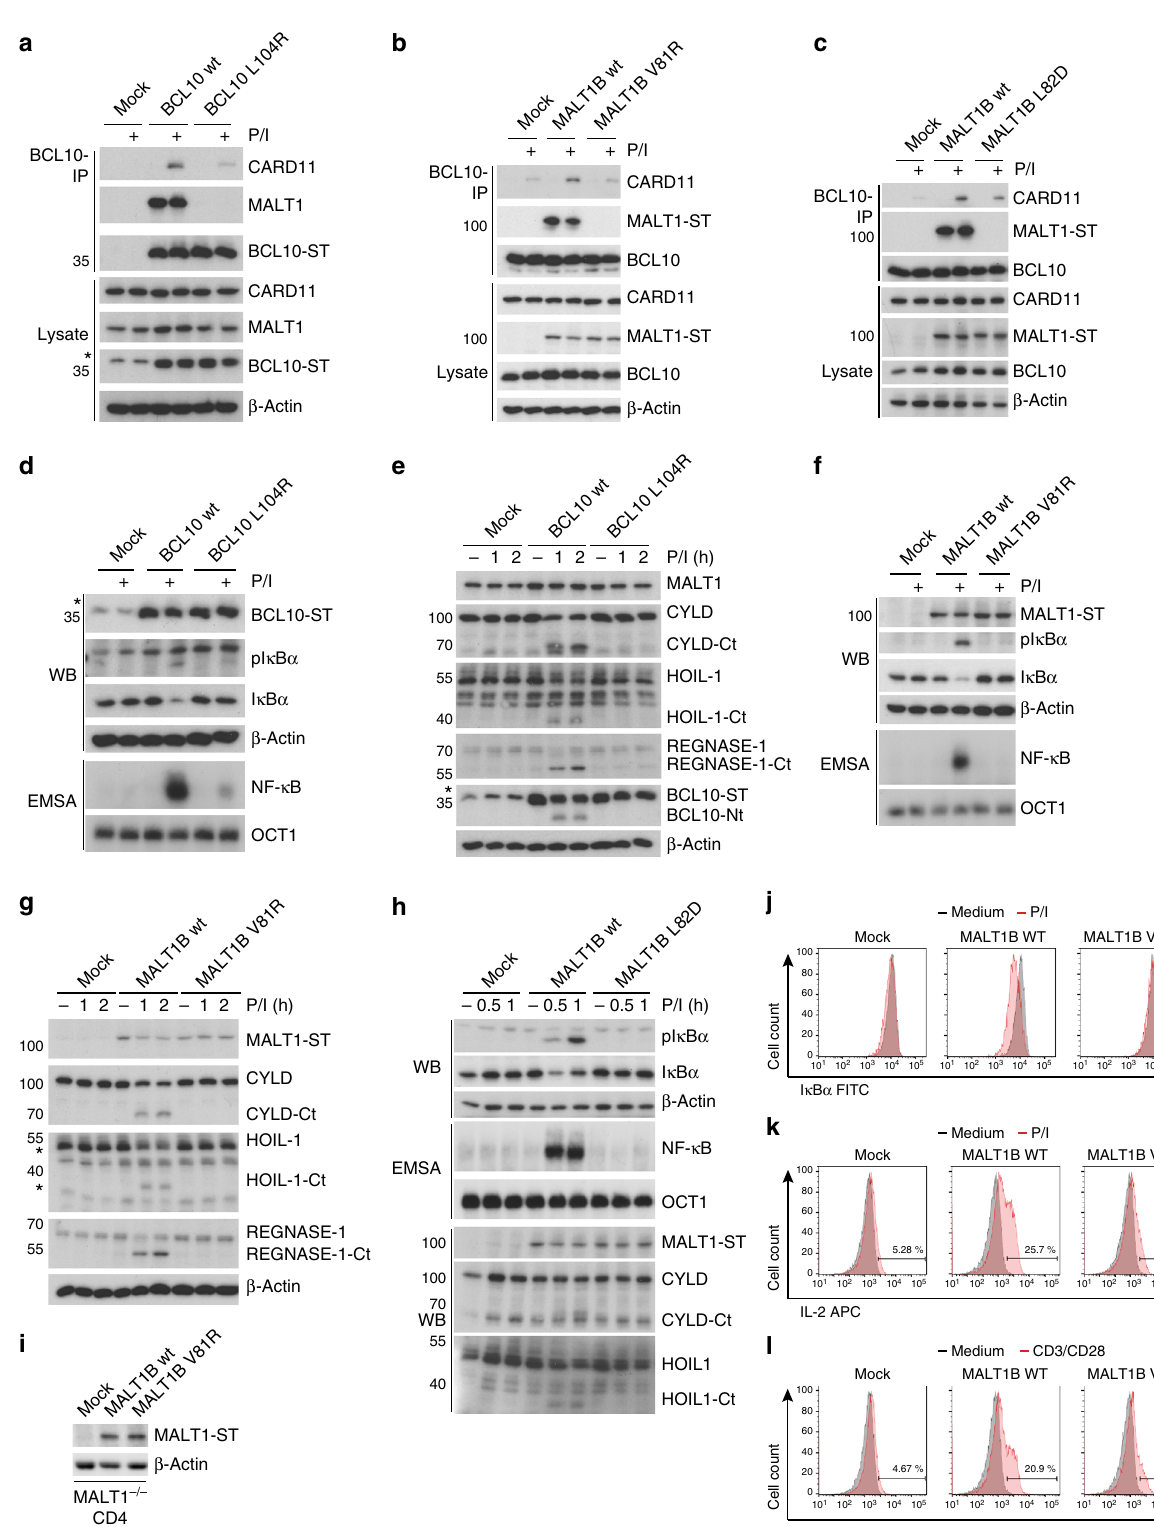
Discussion Our cryo-EM structure resolved the inner core of the BCL10- MALT1 assembly at 4.9 Å resolution. We identi fi ed the BCL10 CARD and MALT1 DD interface BM-I and cell-based assays provide compelling proof that the fi laments channel all CBM downstream signaling events. Since the peripheral